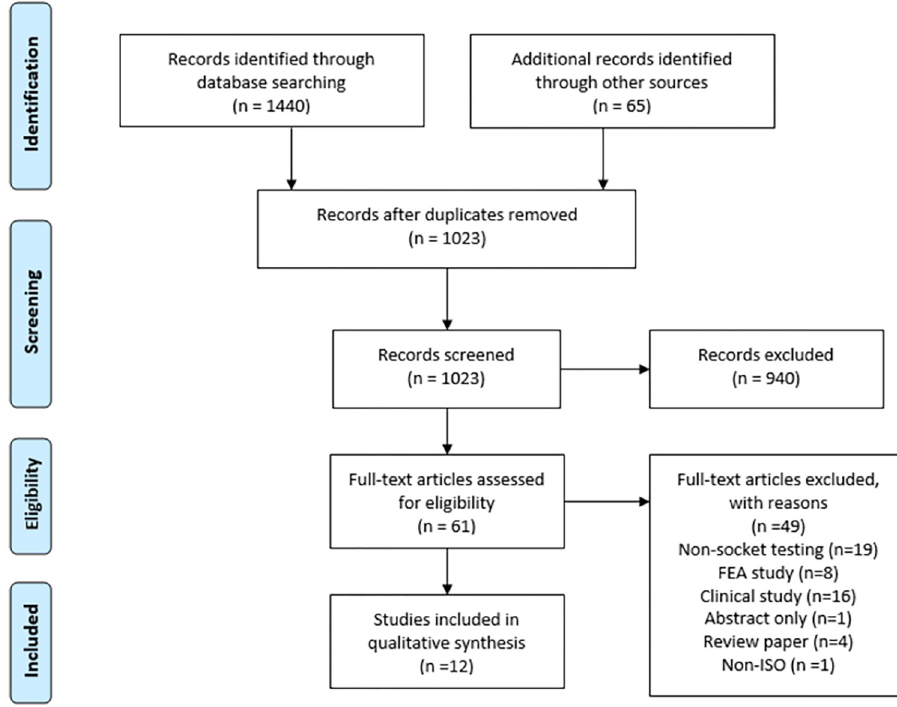
Fig 1. Flow chart of the literature search and study